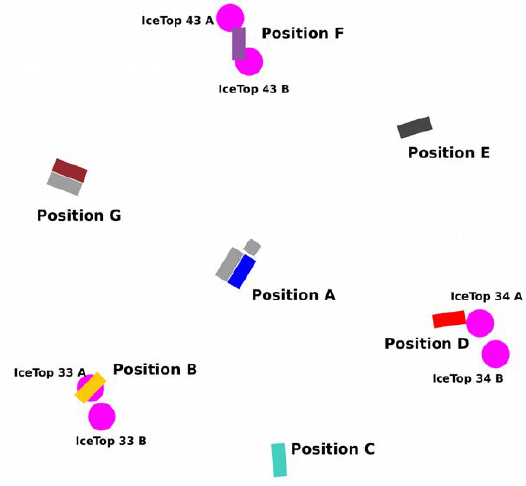
Figure 3. Layout of the prototype scintillator stations at the South Pole around the ice-Cherenkov stations 33, 34, and 43. Partly, the scintillators are installed one above the other, partly side by side. The schematic is not-to-scale, but the distance be- tween the scintillator positions is roughly 60m.